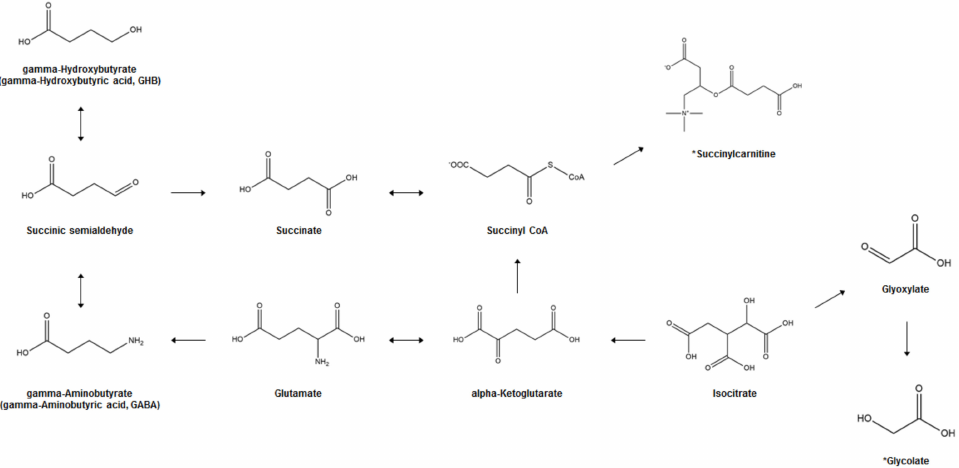
Figure 1. GHB biosynthesis and metabolism and potential biomarkers of GHB exposure. *; Proposed potential